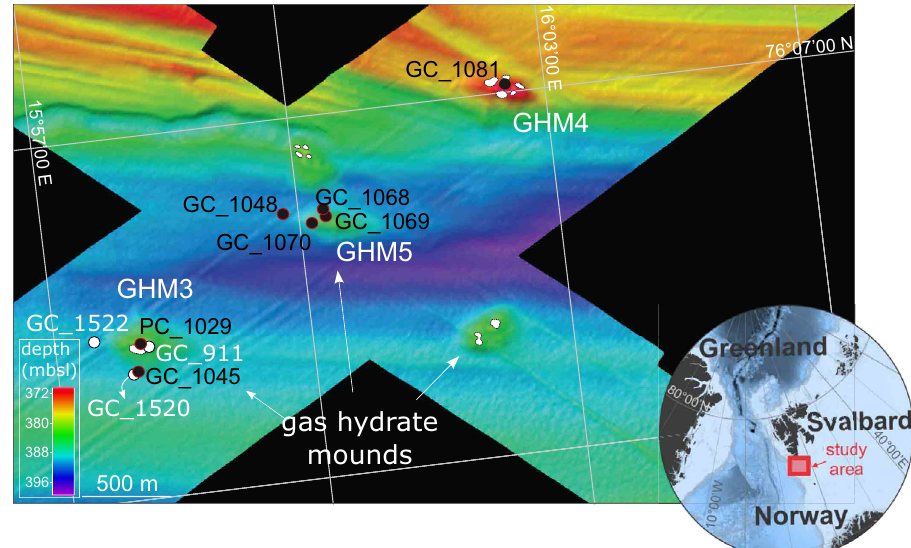
Fig. 1 Bathymetric map of Storfjordrenna gas hydrate mounds and core locations. Storfjordrenna is located south of the Svalbard Archipelago in the red box on the regional map. GHM: gas hydrate mound, GC: gravity core, PC: push core, mbsl: meters below sea level. Black points show cores collected and fi rst described in this study, while white points indicate cores described in previous studies (see Table S3 for a summary of porewater data available from Storfjordrenna). White polygons at GHMs indicate areas of sea fl oor gas release observed at the time of the cruise in